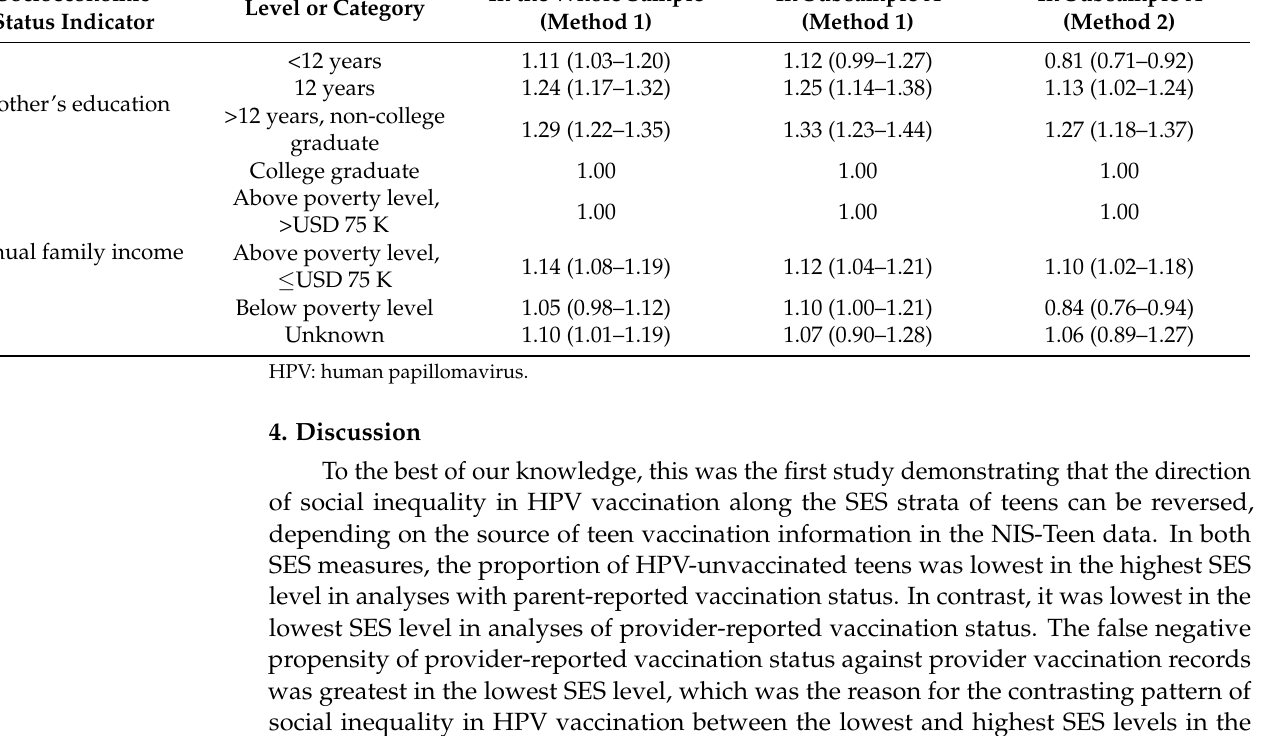
Table 6. The multivariate odds ratios (95% confidence intervals) for HPV-unvaccinated teens (Method 1: parental reports; Method 2: provider records) according to socioeconomic status after controlling for age, sex, race/ethnicity, and region in the whole sample (N = 42,668) and Subsample A (N = 18,788). Odds Ratio (95% Confidence Interval) for HPV-Unvaccinated Teens In the Whole